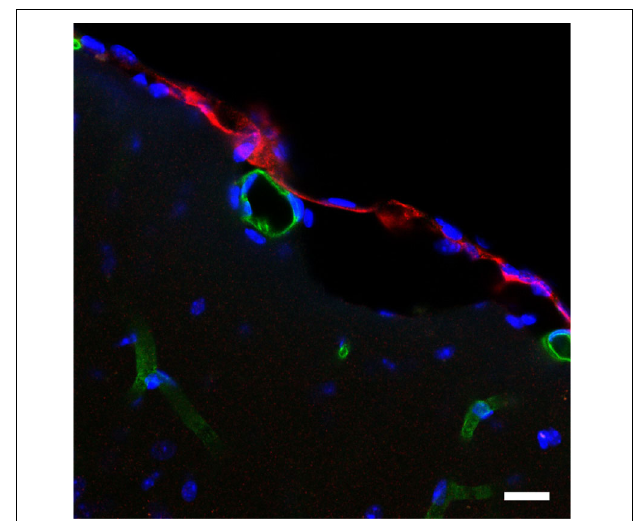
FIGURE 1 | BGT1 is expressed in the leptomeninges. The sections from wildtype and knockout were labeled with anti-BGT1 antibody (red; Ab#590; 1 μ g/ml), and with anti-CD31 antibodies (green; 0.5 μ g/ml; endothelial marker). The images from the sections from knockout mice are not shown here. Scale bars = 20 μ m. Immunochemistry was performed using the same materials and procedures described in detail by Zhou et al. (2012a).